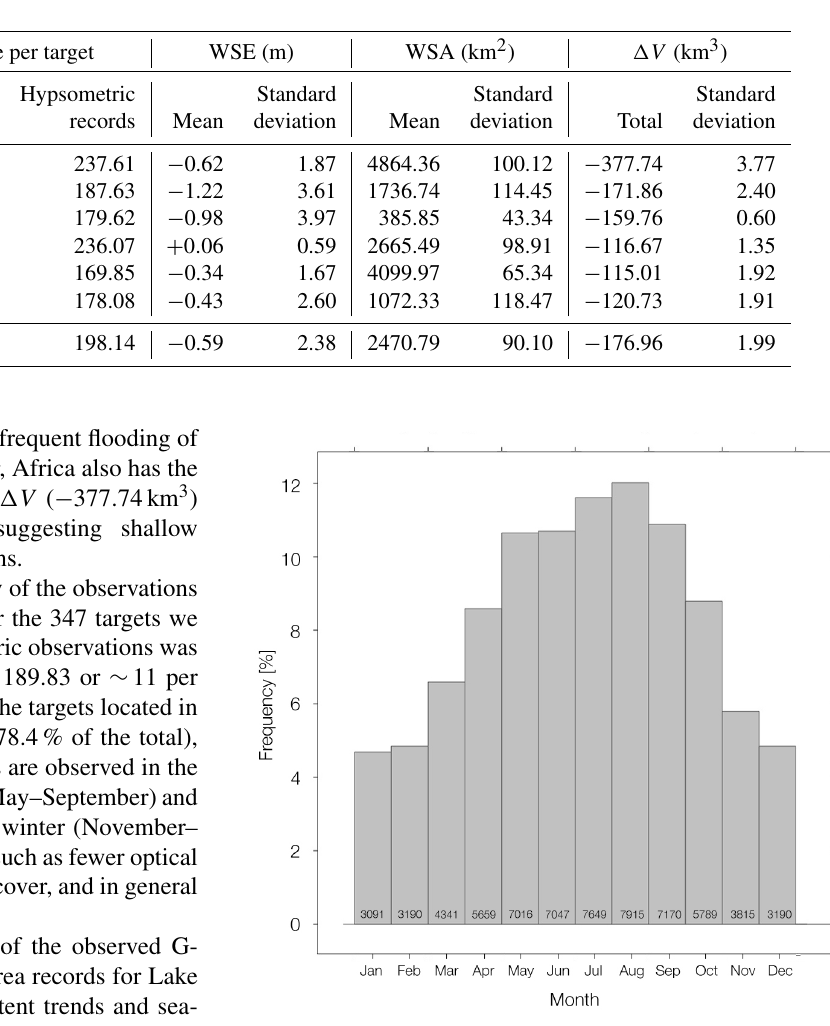
Table 1. Summary by continent of the observed characteristics of the 347 water bodies.